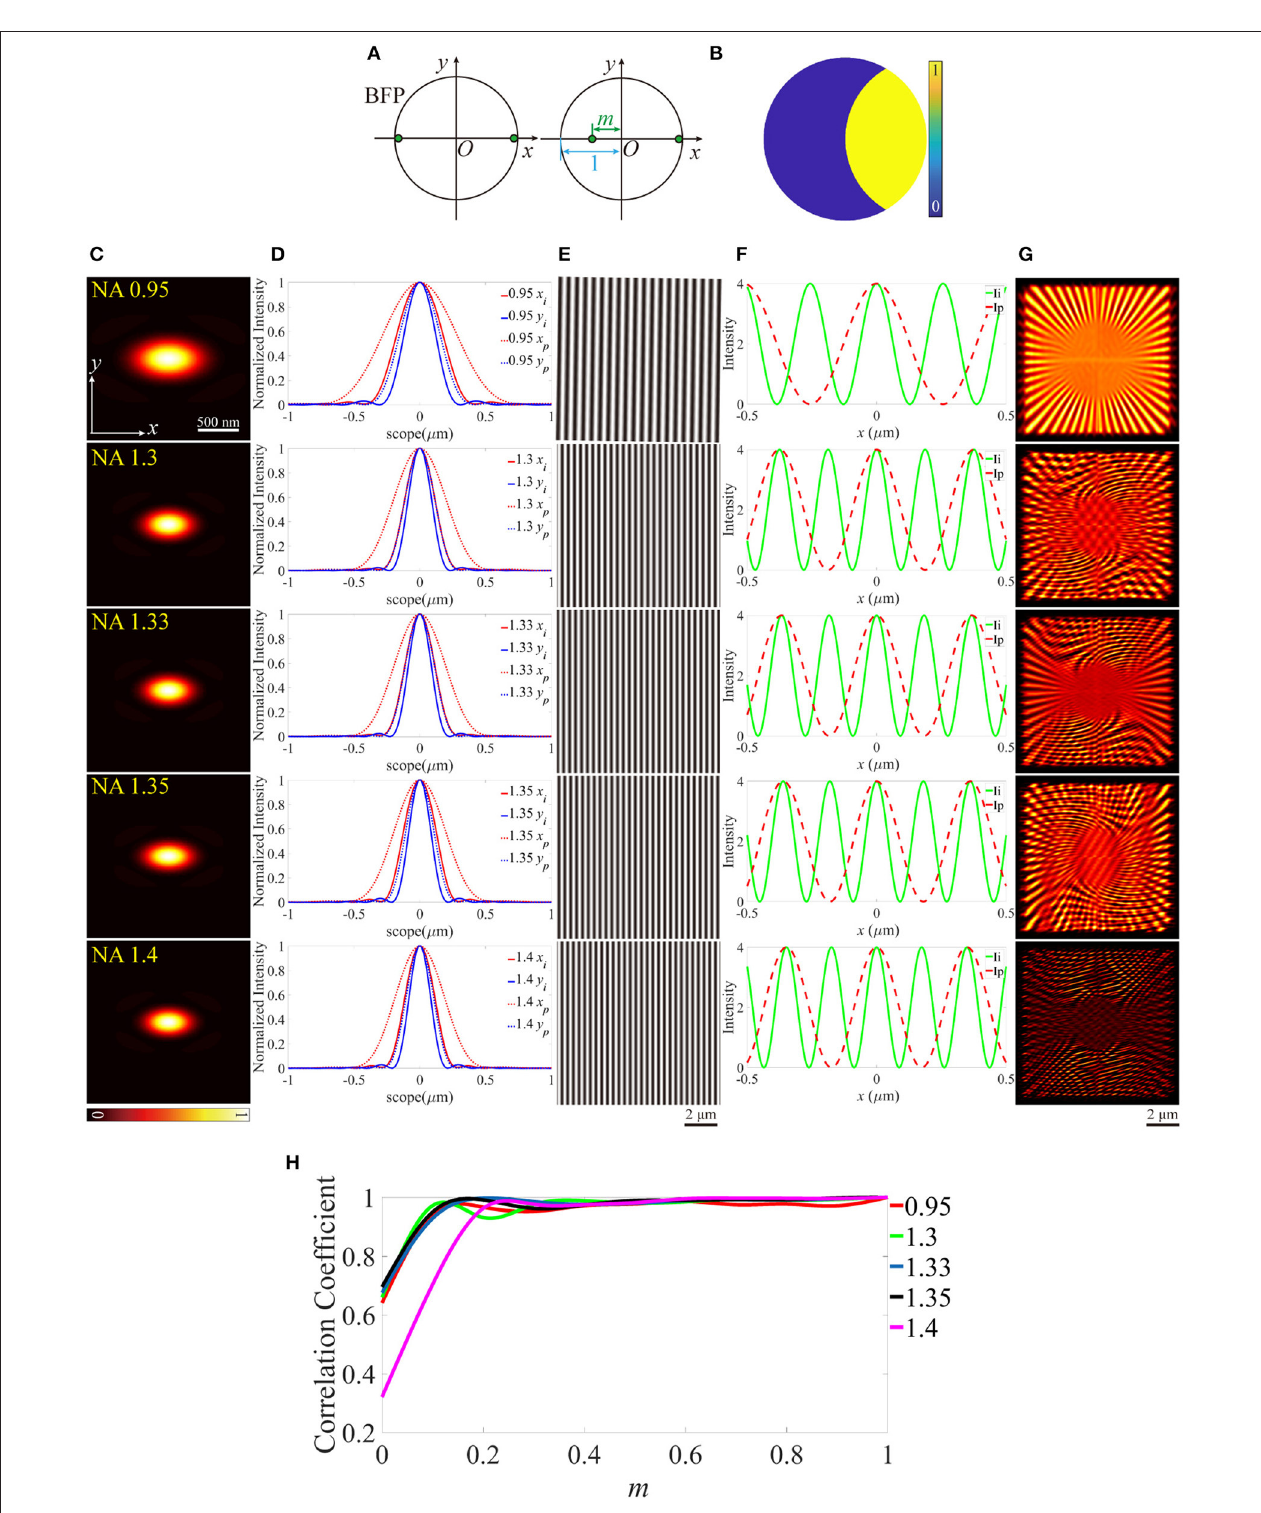
FIGURE 6 | Effects of the off-centered excitation beam. (A) The back focal plane (BFP) of the objectives. (B) The pupil function of the detection path. (C) PSFs on the plane z = 0, calculated from the pupil function in (B) . (D) The profiles of the ideal and biased PSFs in (C) . (E) The excitation patterns. (F) The local profiles of the corresponding excitation patterns shown in (E) , the scope is − 0.5 ∼ 0.5 µ m. (G) The reconstructed images of SIM. m = 0 for all objectives. (H) The correlation coefficients of the biased reconstructed images and the corresponding m .